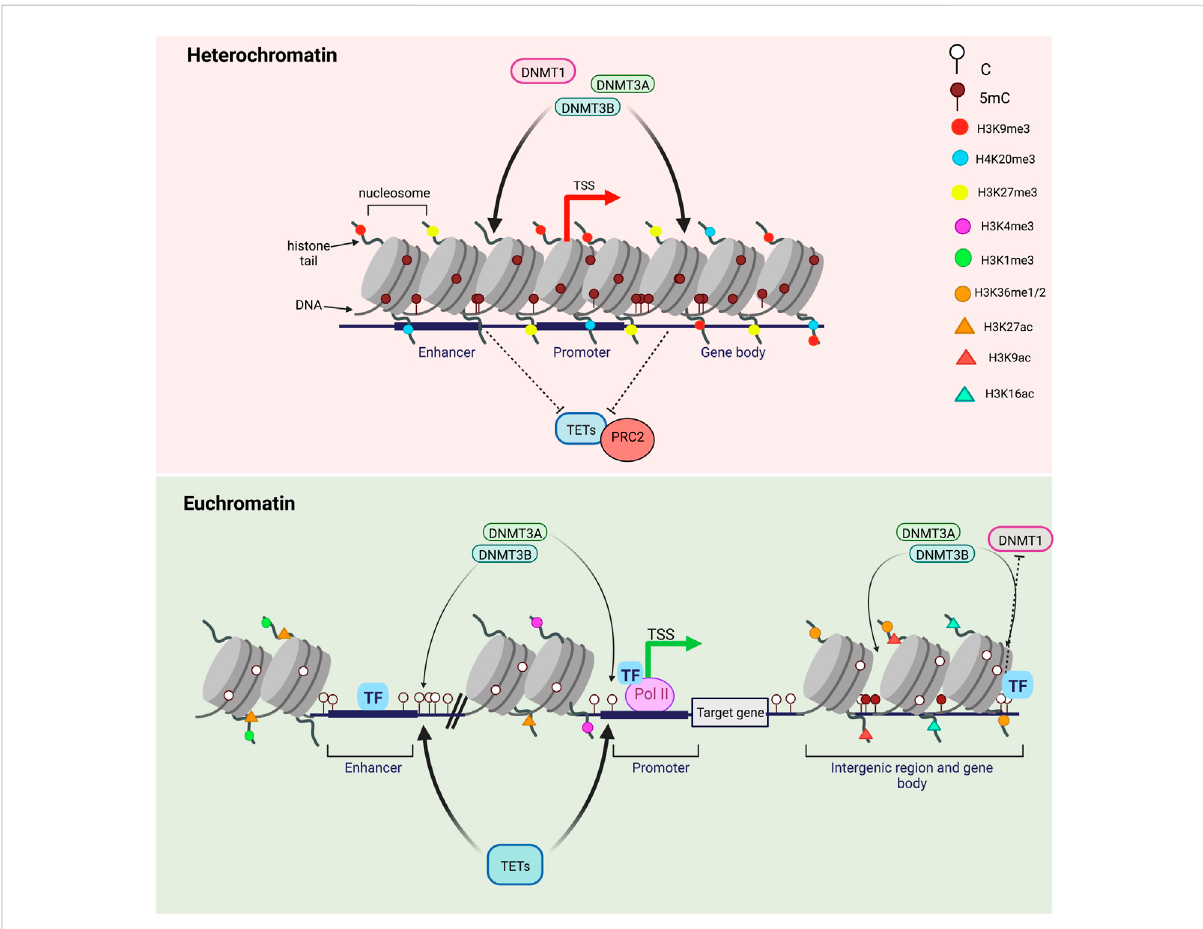
DNA methylation turnover in heterochromatin versus euchromatin. Transcriptionally silent genes are found in highly-condensed chromatin regions called heterochromatin and marked by repressive histone marks H3K9me3, H3K27me3 and H4K20me3. DNA methylation levels in heterochromatin are high and DNA methylation turnover rates are usually low. CpGs in heterochromatic regions are highly methylated by DNMTs and inaccessible by TET proteins. On the opposite, transcriptionally active genes are associated with a less-condensed, nucleosome-depleted and accessible chromatin known as euchromatin. In transcriptionally active regions, gene promoters are enriched in H3K4me3 and H3K27ac, enhancers in H3K4me1 and H3K27ac and gene bodies in H3K9Ac and H3K36me. Highly methylated CpGs within highly transcribed genes, gene bodies and nearby regulatory regions (enhancers and promoters) are subjected to high methylation turnover rates while hypermethylated CpGs within intergenic regions have lower TET and DNMT engagement. Transcription factors binding can regulate both methylation by DNMTs and demethylation by